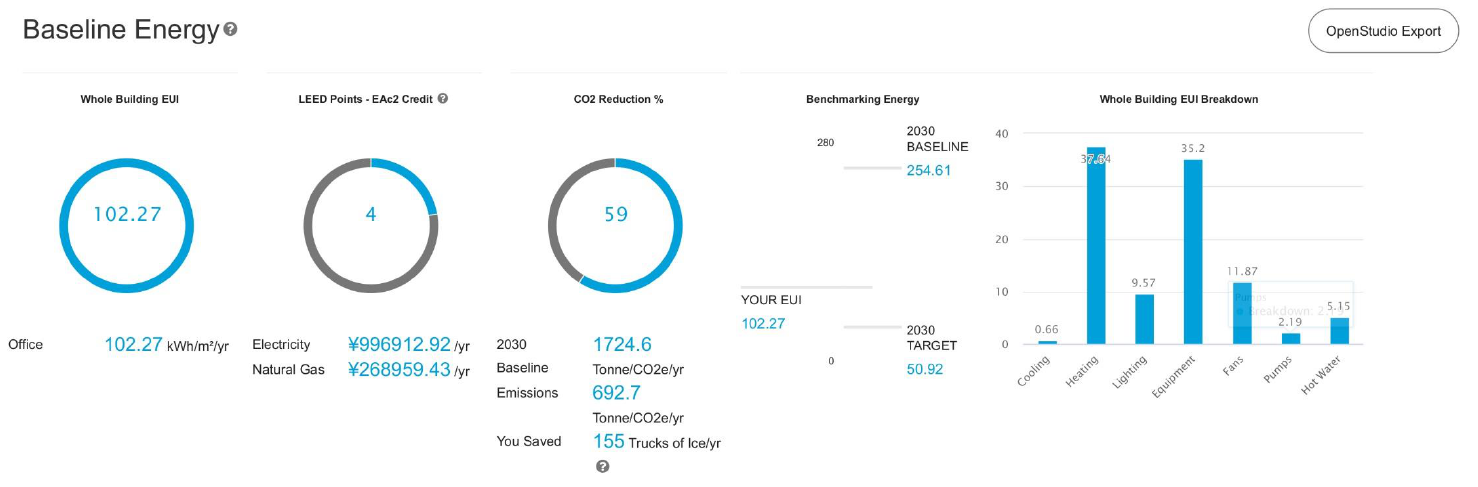
Figure A12. Zone 3-C Kunming, Yunnan (post-COVID-19 84% scenario).